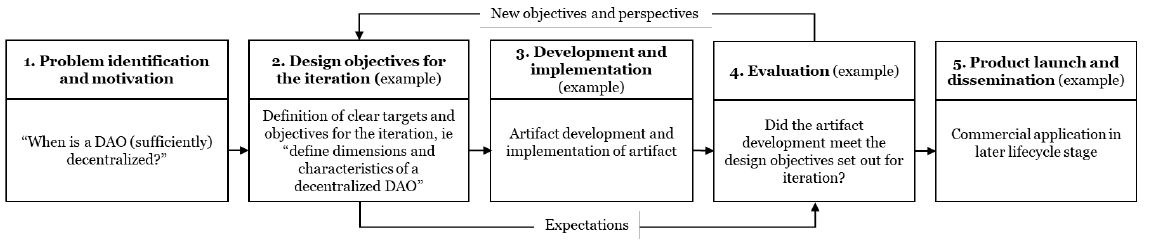
Figure 2. Our search process